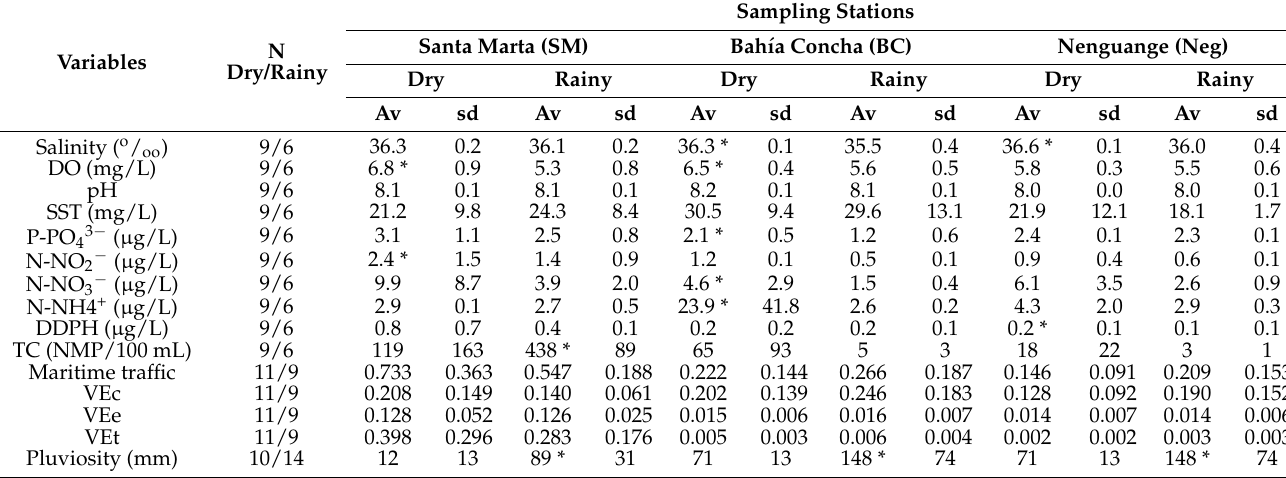
Table 1. Physicochemical and microbiological variables, marine traffic and pluviosity between seasons for studied sites in the coastal fringe of Santa Marta, Colombia, years 2015–2017. N: number of samples; Av: average; sd: standard deviation; (*) denotes significant differences between seasons for each site by Wilcoxon paired comparison test, p < 0.05. Sampling Stations Santa Marta (SM) Bah í a Concha (BC) Nenguange (Neg) N Variables Dry/Rainy Salinity ( o / oo